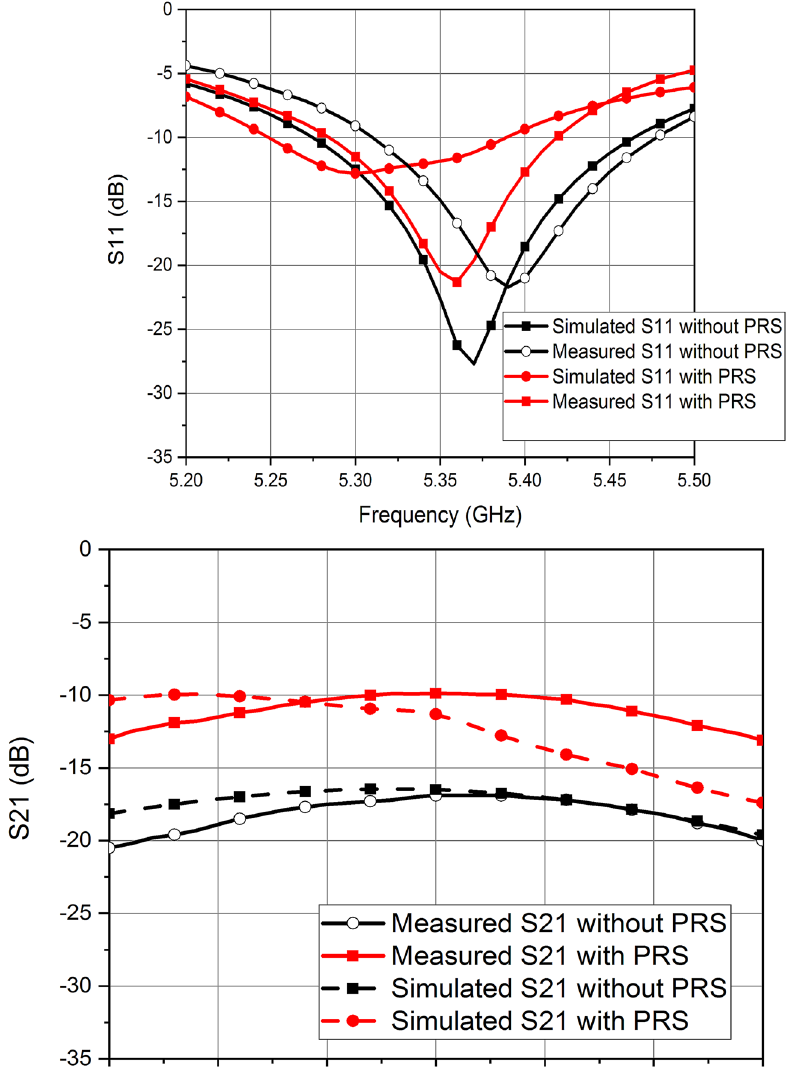
Figure 9. Measured vs Simulated Results.